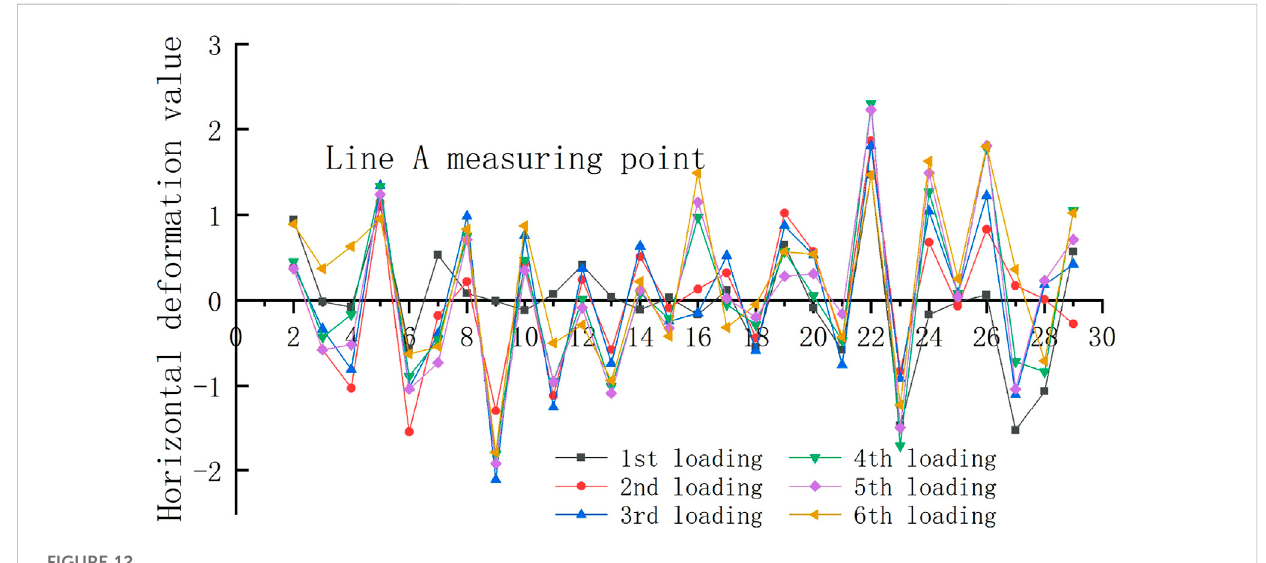
FIGURE 12 Surface relative horizontal deformation curve after